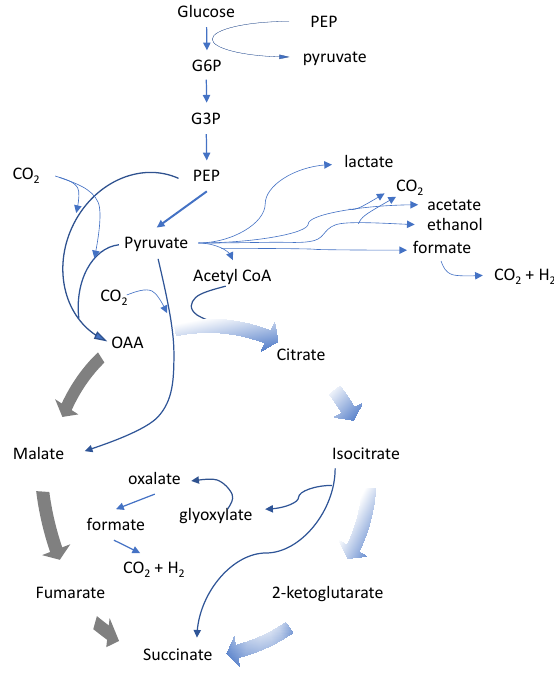
Figure 1. Metabolic pathways to succinic acid. Thick grey arrows showing the reductive (anaerobic) and thick blue arrows indicating the oxidative (aerobic) tricarboxylic acid (TCA) cycle. Thin blue arrows indicate contributing reactions and alternative pathways to succinic acid. Co-factors and electron balances were omitted for clarity. Notes: G6P: glucose-6-phosphate; G3P: glyceraldehyde-3-phosphate; OAA: oxaloacetate; PEP: